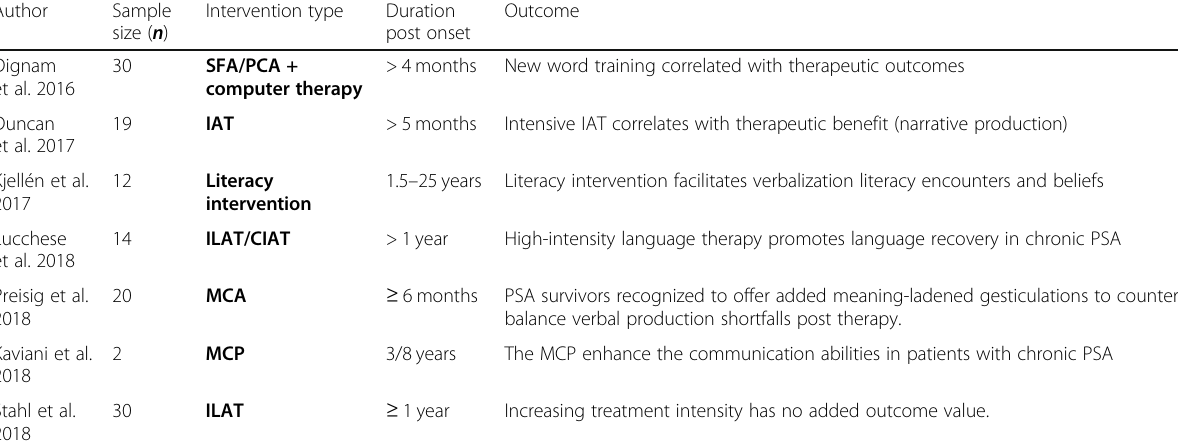
Table 2 Summing researches published (2016 – February 2020) appraising the effectiveness of speech-language therapy on subacute and chronic vascular